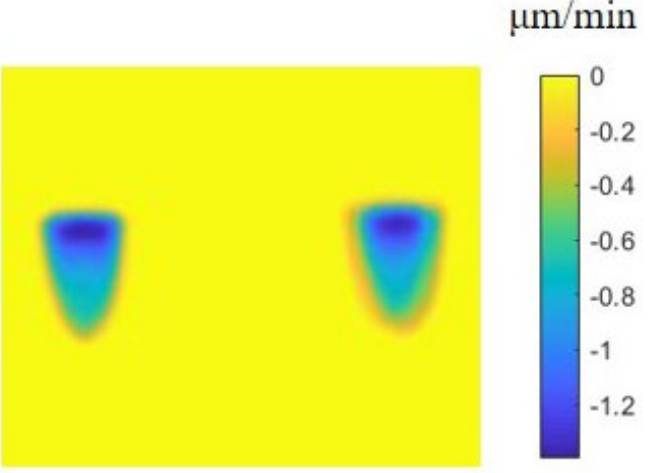
Figure 12. Removal function of array-type magnetorheological polishing technology.